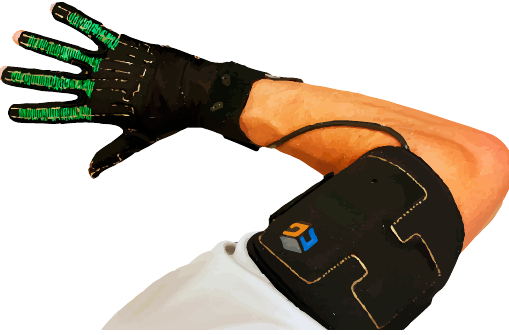
Figure 4. CyberGlove III mainly used to control robots.